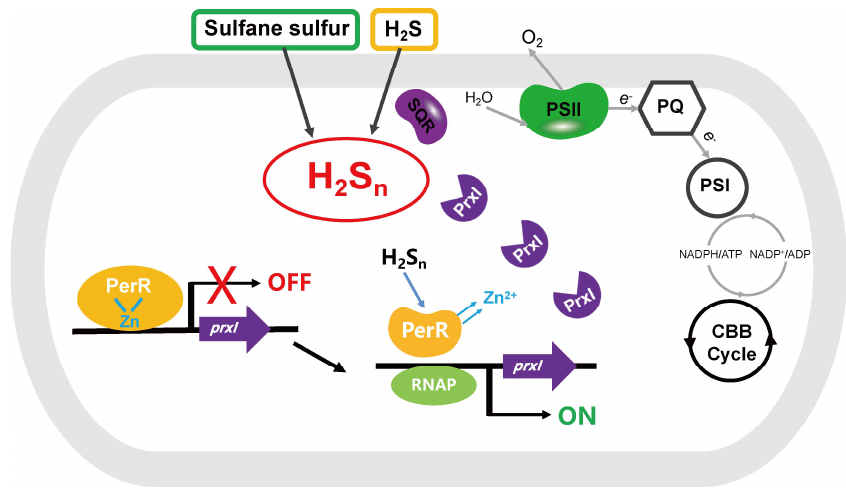
Figure 6. PerR senses H 2 S n and regulates the expression of prxI in PCC7002. H 2 S n induces the expression of prxI via PerR. PerR binds to Zn 2+ and acts on the promoter of prxI to inhibit its expression, a process that can be disinhibited by H 2 S n . H 2 S n acts on the Cys4:Zn 2+ site of PerR to relieve Zn 2+ , destroying the zinc finger structure. C 121 -SH in the Cys4:Zn 2+ site is modified by H 2 S n and forms C 121 -SSH.